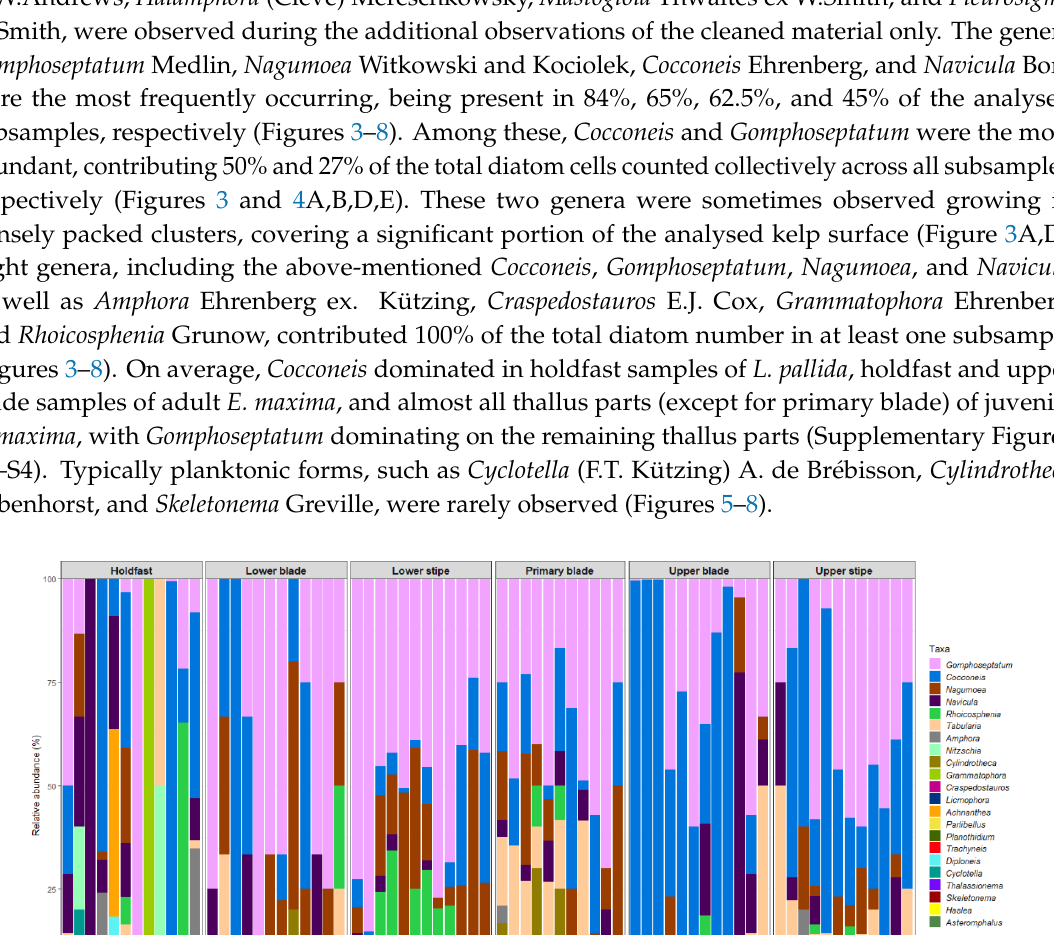
Figure 5. Relative abundance of diatom genera on different parts of adult specimens of Ecklonia maxima .